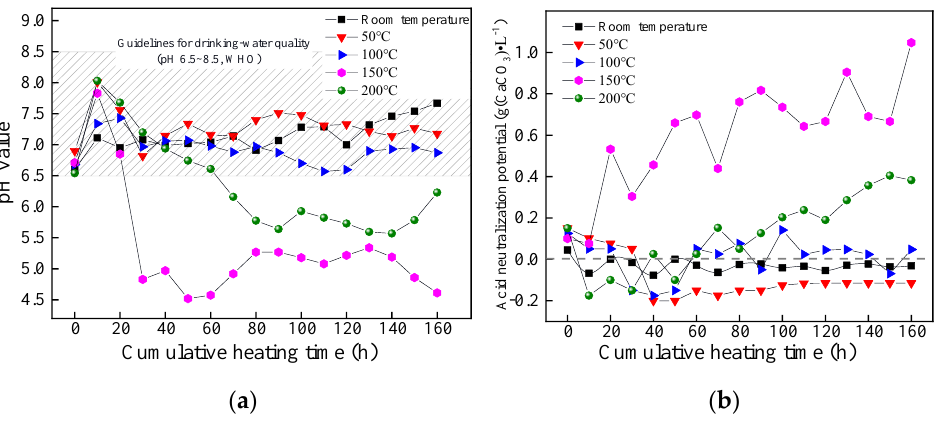
Figure 5. Variations of ( a ) pH value and ( b ) ANP of coal gangue leaching solution at di ff erent